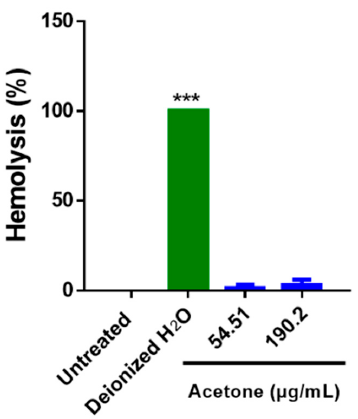
Figure 9. S. triloba acetone extract does not induce hemolysis in human erythrocytes. Hemolytic